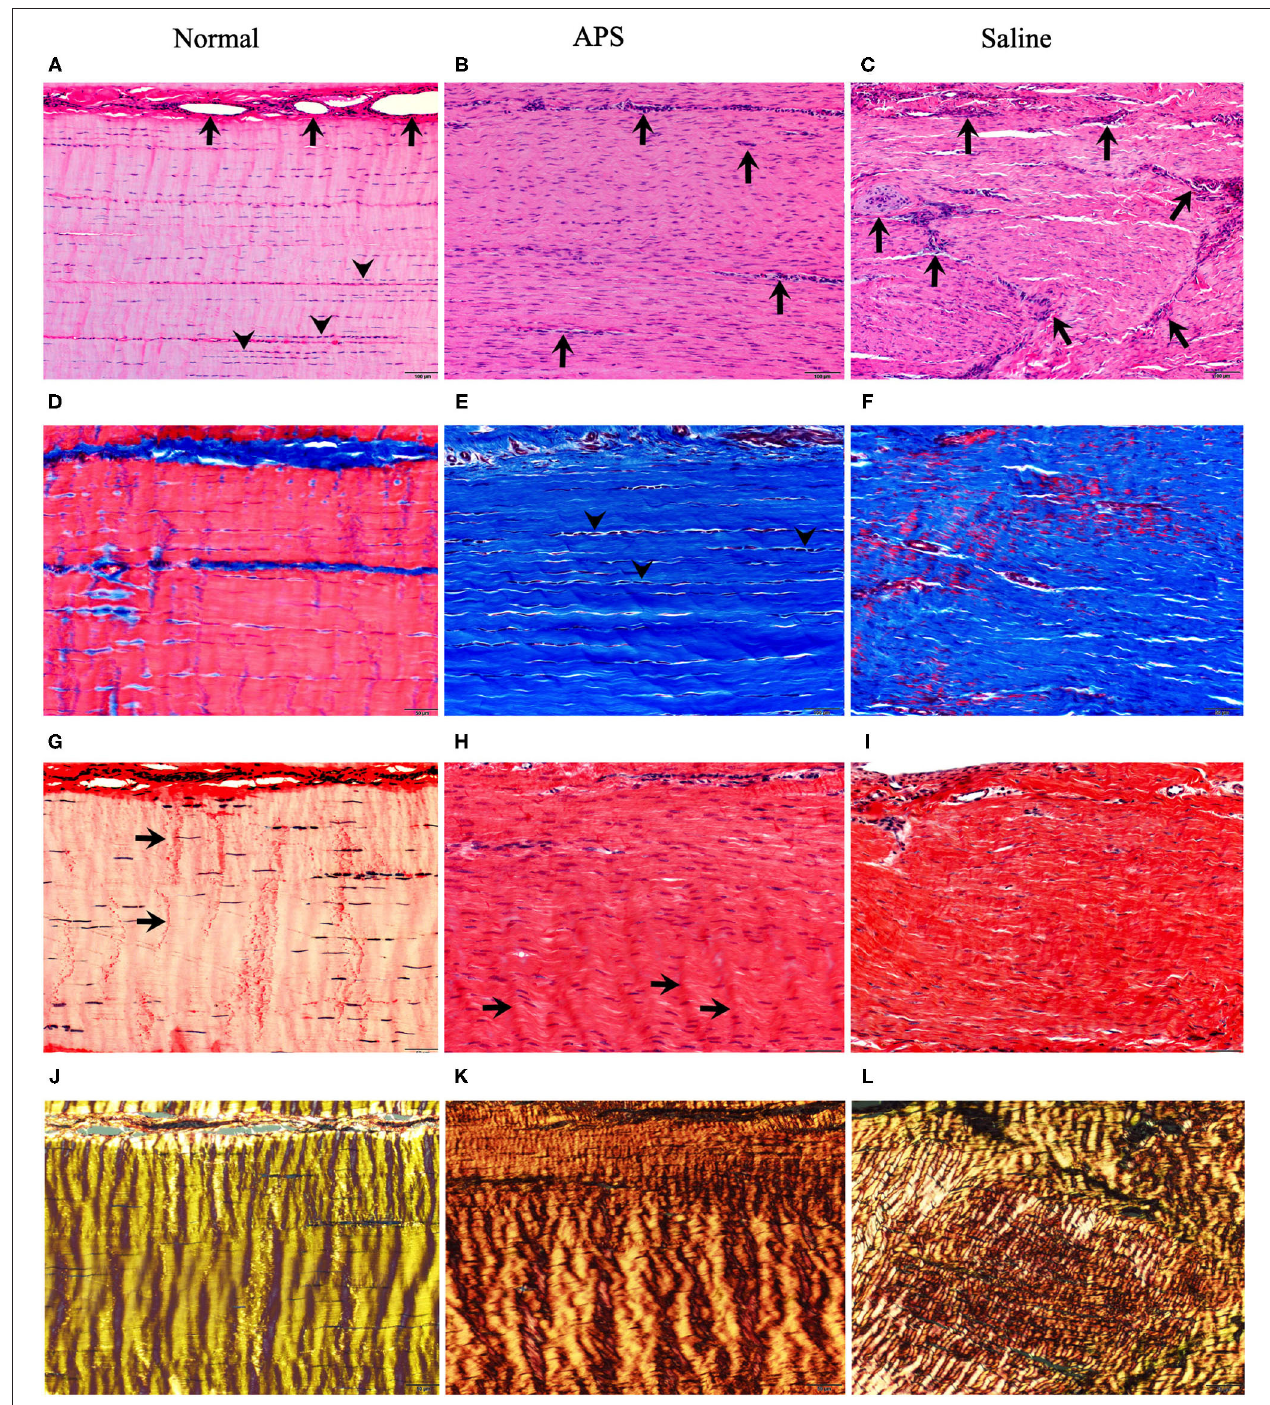
FIGURE 4 | Photomicrographs stained with H&E (A–C) Masson’s trichrome (MTC) (D–F) and Picrosirius red examined under unpolarized (PSR) (G–I) and polarized (PSR-P) (J–L) light for normal ( left panels ), APS treated ( middle panels ) and saline treated ( right panels ) tendons. H&E stains show in normal tendons (A) blood vessels ( arrows ) are limited to endotendinous septae with multifocal nuclear rowing ( arrowheads ), compatible with mild degeneration. In contrast, APS (B) and saline-treated (C) tendons contain increased numbers of small caliber blood vessels randomly interspersed among regenerating tendon fibers which have increased, uniformly dispersed numbers of tenocyte nuclei (10 × magnification; bars = 100 µ m). MTC stains of normal tendons (D) show red staining of well-defined linear arrays of tendon fibers compared to APS (E) and saline (F) treated tendons that show blue staining of tendon fibers, but APS treated tendons have increased parallel alignment of tendon fibers with linearly-aligned tenocyte nuclei ( arrowheads ) compared to saline treated tendons (20 × magnification; bars = 50 µ m). PSR stained sections of normal tendons (G) show uniform crimp ( arrows ) with few numbers of thin, wavy tenocyte; APS (H) and saline (I) treated tendons have